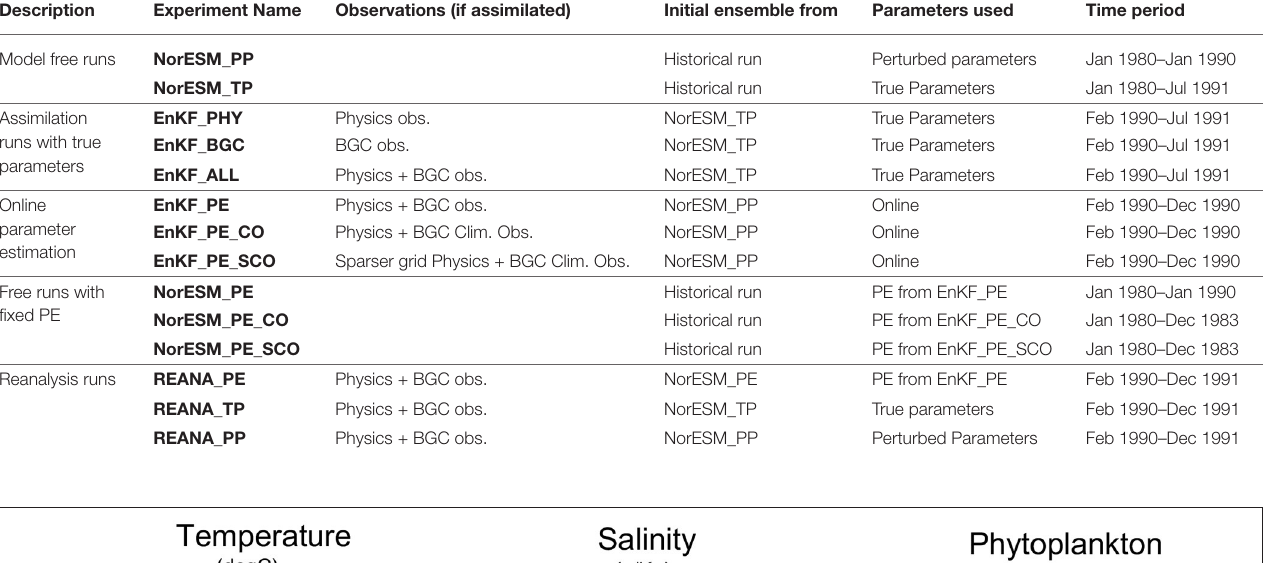
TABLE 1 | List of performed experiments.